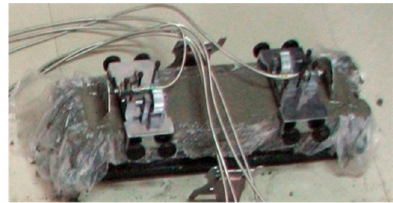
Figure 6. Autogenous shrinkage test.